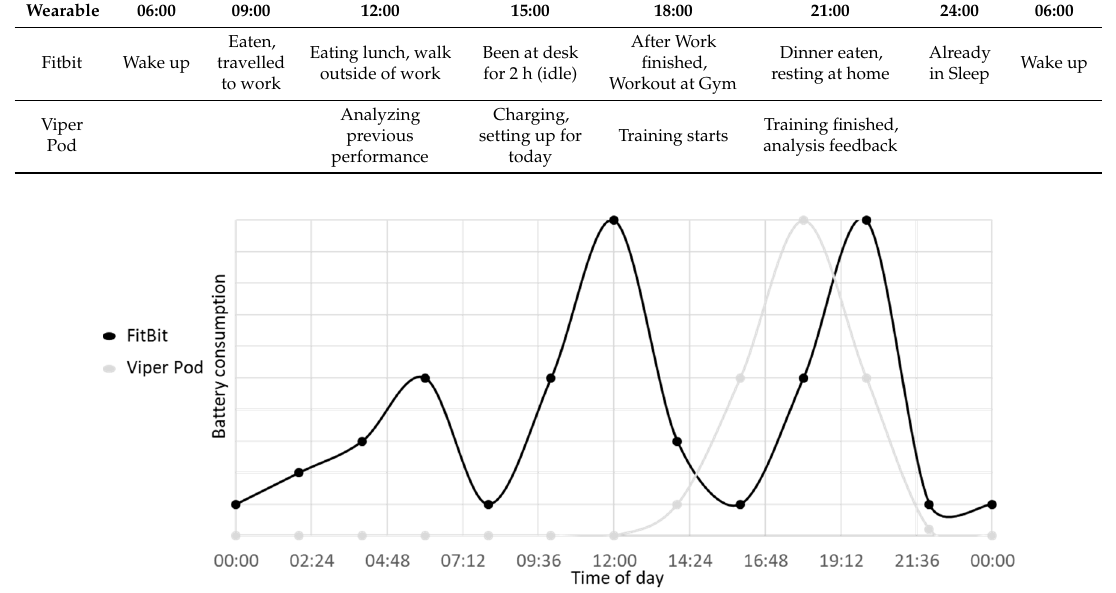
Table 3. Example in comparing di ff erent stages of Fitbit and Viper PODS throughout a day.